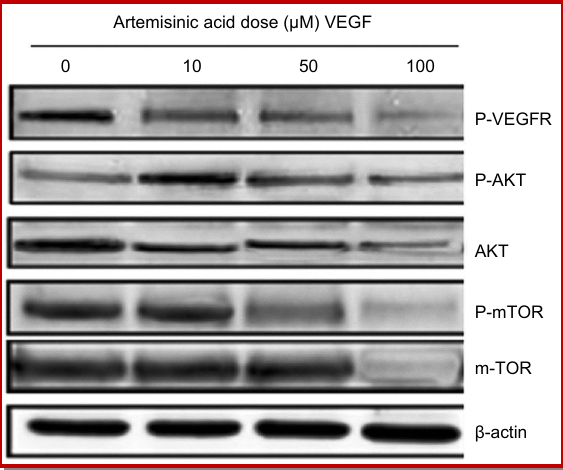
Figure 4: Effect of artemisinic acid on VEGFR2, AKT and m- TOR signalling pathways evaluated by Western blot assay. Artemisinic acid could suppressed the activation of VEGFR along with inhibiting m-TOR signalling